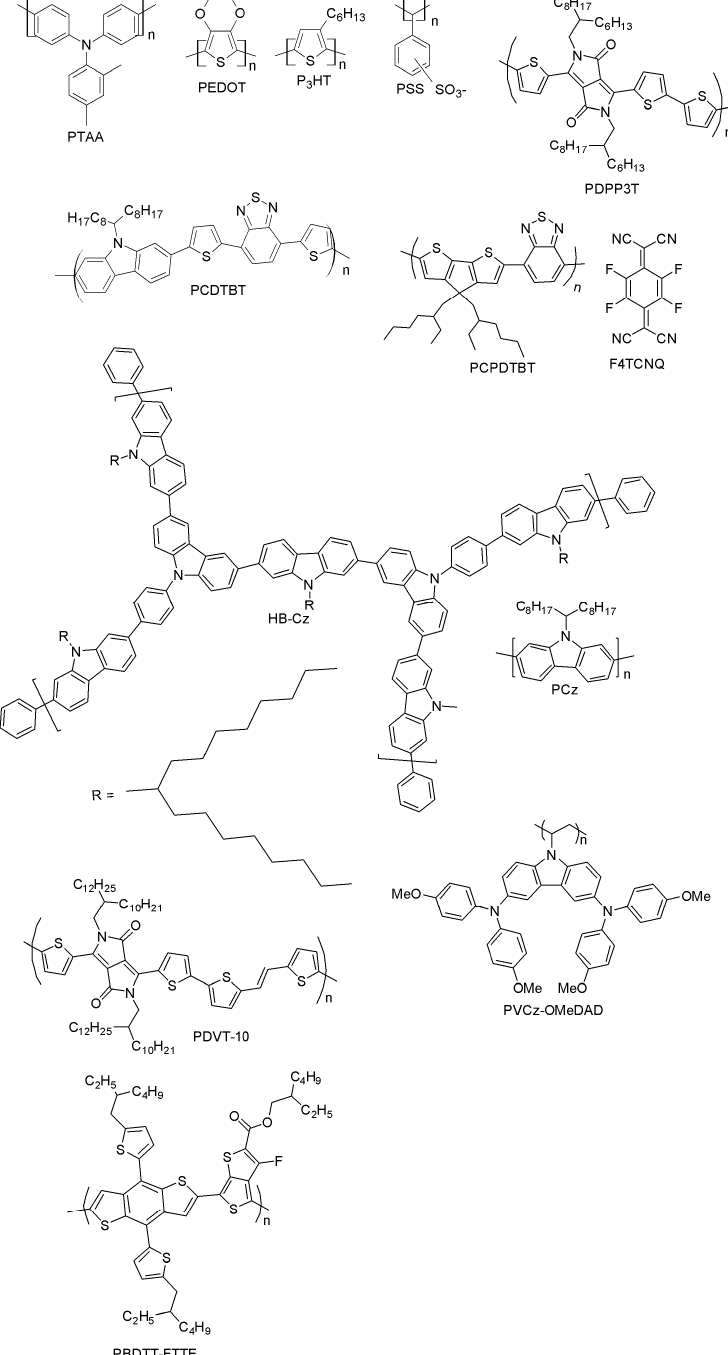
Figure 20. Polymer-based HTMs.